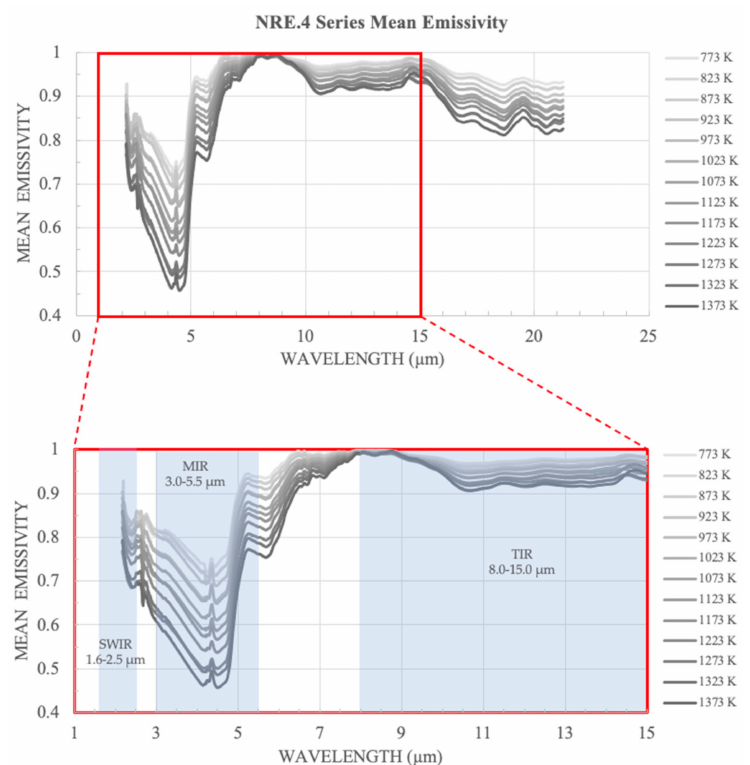
Figure 4. ( Top panel ) Emissivity spectra of basaltic samples, acquired using FTIR emission spec- troscopy at a range of sample temperatures from 1373 to 773 K; ( bottom panel ) indicating emissivity– temperature trends in the region(s) of interest (SWIR, MIR and TIR). The samples are trachy-basaltic lavas belonging to the individual lava flow (Figure 1) emplaced between 18 July to 9 August 2001 [7]. Overall, the average emissivity increases as the temperature of the samples decreases in a nonlinear inverse